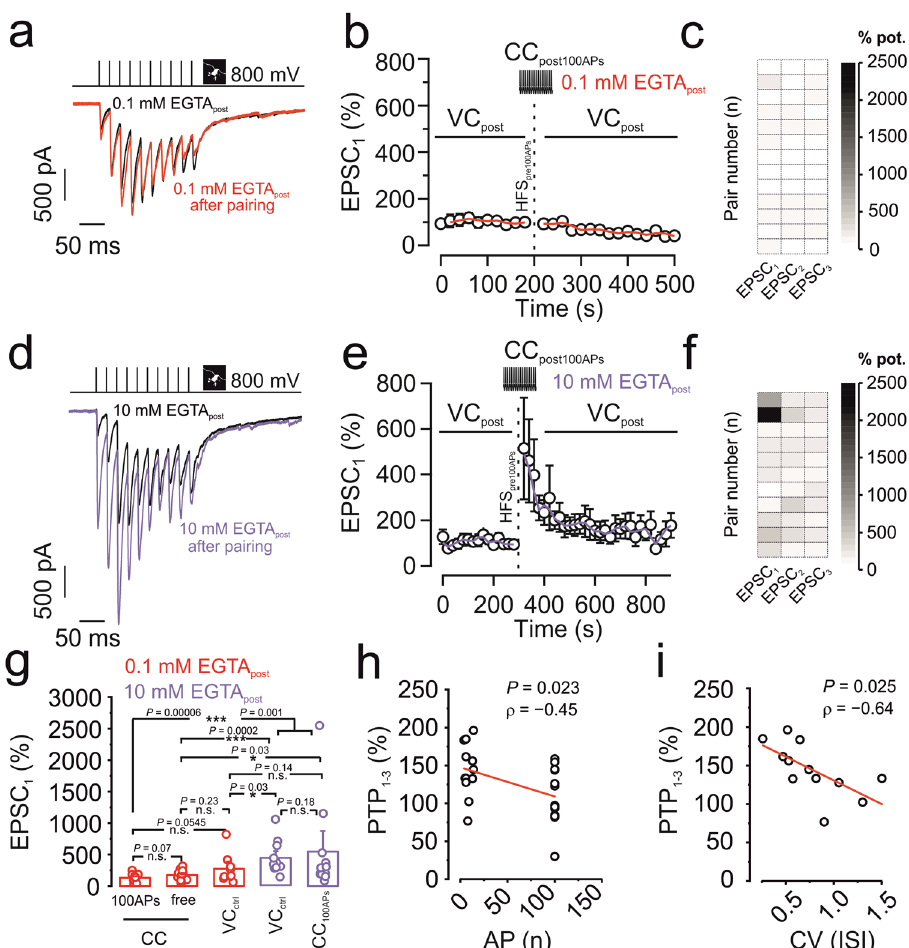
Fig. 2 Anti-associative induction properties of mossy fi ber PTP. a – c Pre + post HFS 100 fails to induce PTP with 0.1 mM EGTA in the postsynaptic pipette. a Representative traces of control (black) and after HFS 100 pairing (red). b Normalized EPSC 1 amplitude plotted versus experimental time. Black vertical dashed line indicates delivery of an HFS 100 stimulation (1 s, 100 Hz) in tight-seal cell-attached mode at the level of the MFB, combined with pairing 100 postsynaptic APs in current-clamp mode. Red line shows running average. Data from 13 pairs. c Intensity map showing the degree of potentiation of the fi rst three EPSCs (in %, with control values plotted as 100%) of each single pair between an MFB and a CA3 pyramidal cell, upon pairing with 0.1 mM EGTA in the postsynaptic pipette. d – f Pre + post HFS 100 triggers full PTP with 10 mM EGTA in the postsynaptic pipette. d Representative traces of control (black) and after HFS 100 pairing (violet). e Normalized EPSC 1 amplitude plotted versus experimental time. Black vertical dashed line indicates delivery of an HFS 100 stimulation (1 s, 100 Hz) in tight-seal cell-attached mode at the level of the MFB, combined with pairing 100 postsynaptic APs in current-clamp mode. Violet line shows running average. Data from 11 pairs. f Intensity map showing the degree of potentiation of the fi rst three EPSCs (in %) of each MFB – CA3 pyramidal neuron pair, with 10 mM EGTA postsynaptically. g Summary bar graphs showing the percentage of potentiation of EPSC 1 by pairing 100 presynaptic APs with or without postsynaptic APs with different concentrations of the Ca 2 + chelator EGTA. Red bar graphs represent pairs where 0.1 mM EGTA was included in the postsynaptic pipette. Violet bar graphs represent pairs where 10 mM EGTA was included in the postsynaptic pipette. CC 100APs refers to a – c and d – f (above). CC free refers to experiments where the postsynaptic cell was allowed to spike freely in current-clamp mode upon presynaptic HFS 100 . VC ctrl in the presence of 10 mM EGTA refers to data published in Vandael et al. 10 , where the postsynaptic cell was under voltage- clamp control to prevent spiking. Boxes represent mean values, and circles show individual measurements. A non-paired non-parametric two-sided Mann – Whitney U test was used to test for statistical signi fi cance. * indicates P < 0.05, ** P < 0.01, *** P < 0.001, and n.s. denotes non-signi fi cant difference ( P ≥ 0.05). P values are given without multiple comparison correction. Data from 13, 12, 9, 12, and 11 pairs. h Scatter plot of magnitude of PTP against number of APs of the postsynaptic CA3 pyramidal neuron. The degree of PTP refers to the average PTP obtained for the fi rst three EPSCs (EPSC 1 – 3 ). Note a signi fi cant correlation. Line represents linear regression to the data points (Pearson ’ s correlation coef fi cient ρ = − 0.45; P = 0.023; 25 pairs; 13 with CC 100APs and 12 with CC free ). i Scatter plot of magnitude of PTP against coef fi cient of variation (CV) of ISI duration of the postsynaptic CA3 pyramidal neuron. The degree of PTP refers to the average PTP obtained for the fi rst three EPSCs (EPSC 1 – 3 ). Data points taken from postsynaptic CC free recordings upon presynaptic HFS 100 . Note a signi fi cant correlation. Line represents linear regression to the data points (Pearson ’ s correlation coef fi cient ρ = − 0.64; P = 0.025; 12 pairs). Error bars indicate voltage-clamp conditions with 0.1 mM EGTA was intermediate were near the limits of statistical signi fi cance ( P = 0.03 and P = (273.0 ± 82.2%; from 169.7 ± 56.9 pA to 290.0 ± 72.4 pA; 9 pairs) 0.144, respectively; Fig. 2g). Taken together, our results suggest between PTP with 100 APs in current clamp in 0.1 mM EGTA ( P that patterned forms of postsynaptic activity are suf fi cient to put a = 0.055; Fig. 2g) and PTP with voltage-clamp or current-clamp brake on mossy fi ber PTP. Recent work demonstrated that PTP induction with 100 APs in 10 mM EGTA, although all differences could be attributed to a transient increase in the size of the RRP 10 .